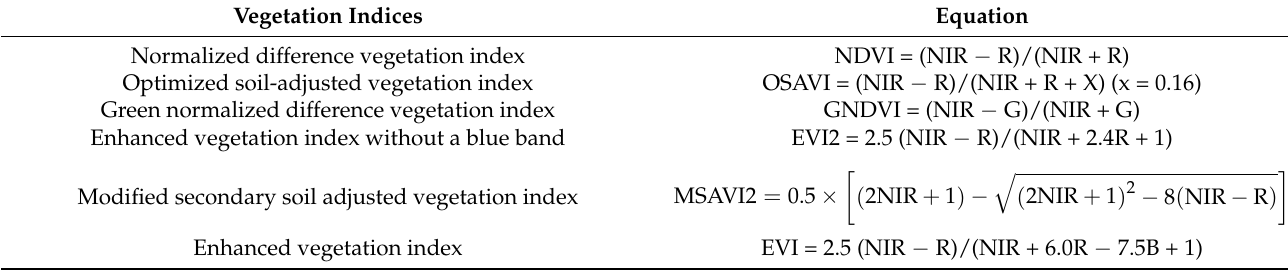
Table 4. Vegetation indices used in this